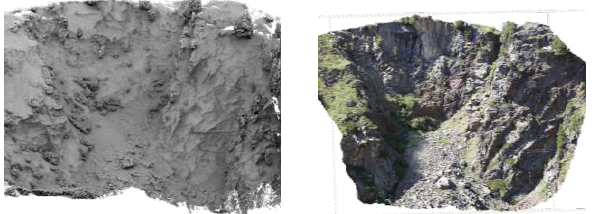
Figure 3. Left image represent the TLS mesh model used as reference point cloud. Right image shows the textured model from photogrammetric-based point cloud of rockfall site.